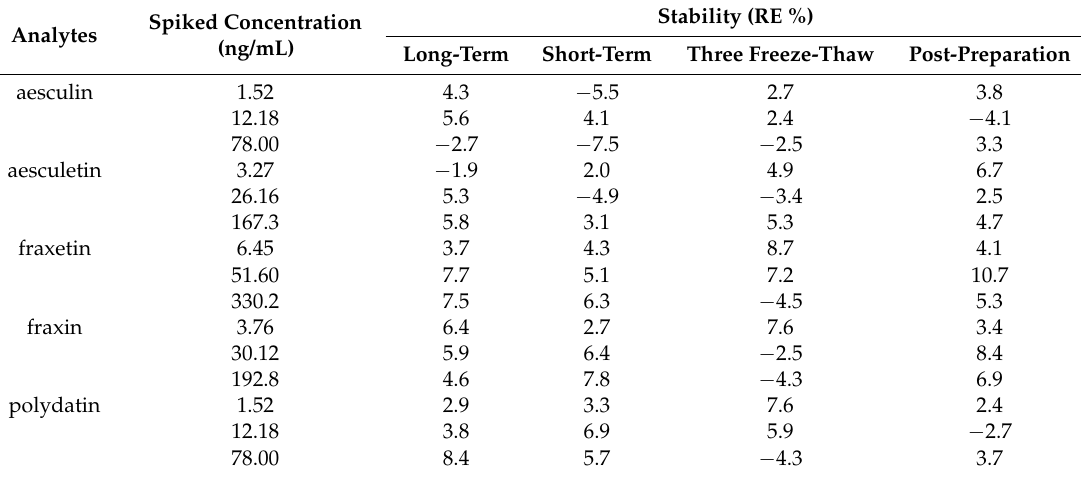
Table 5. Stability of analytes in beagle dog plasma under various conditions (n =